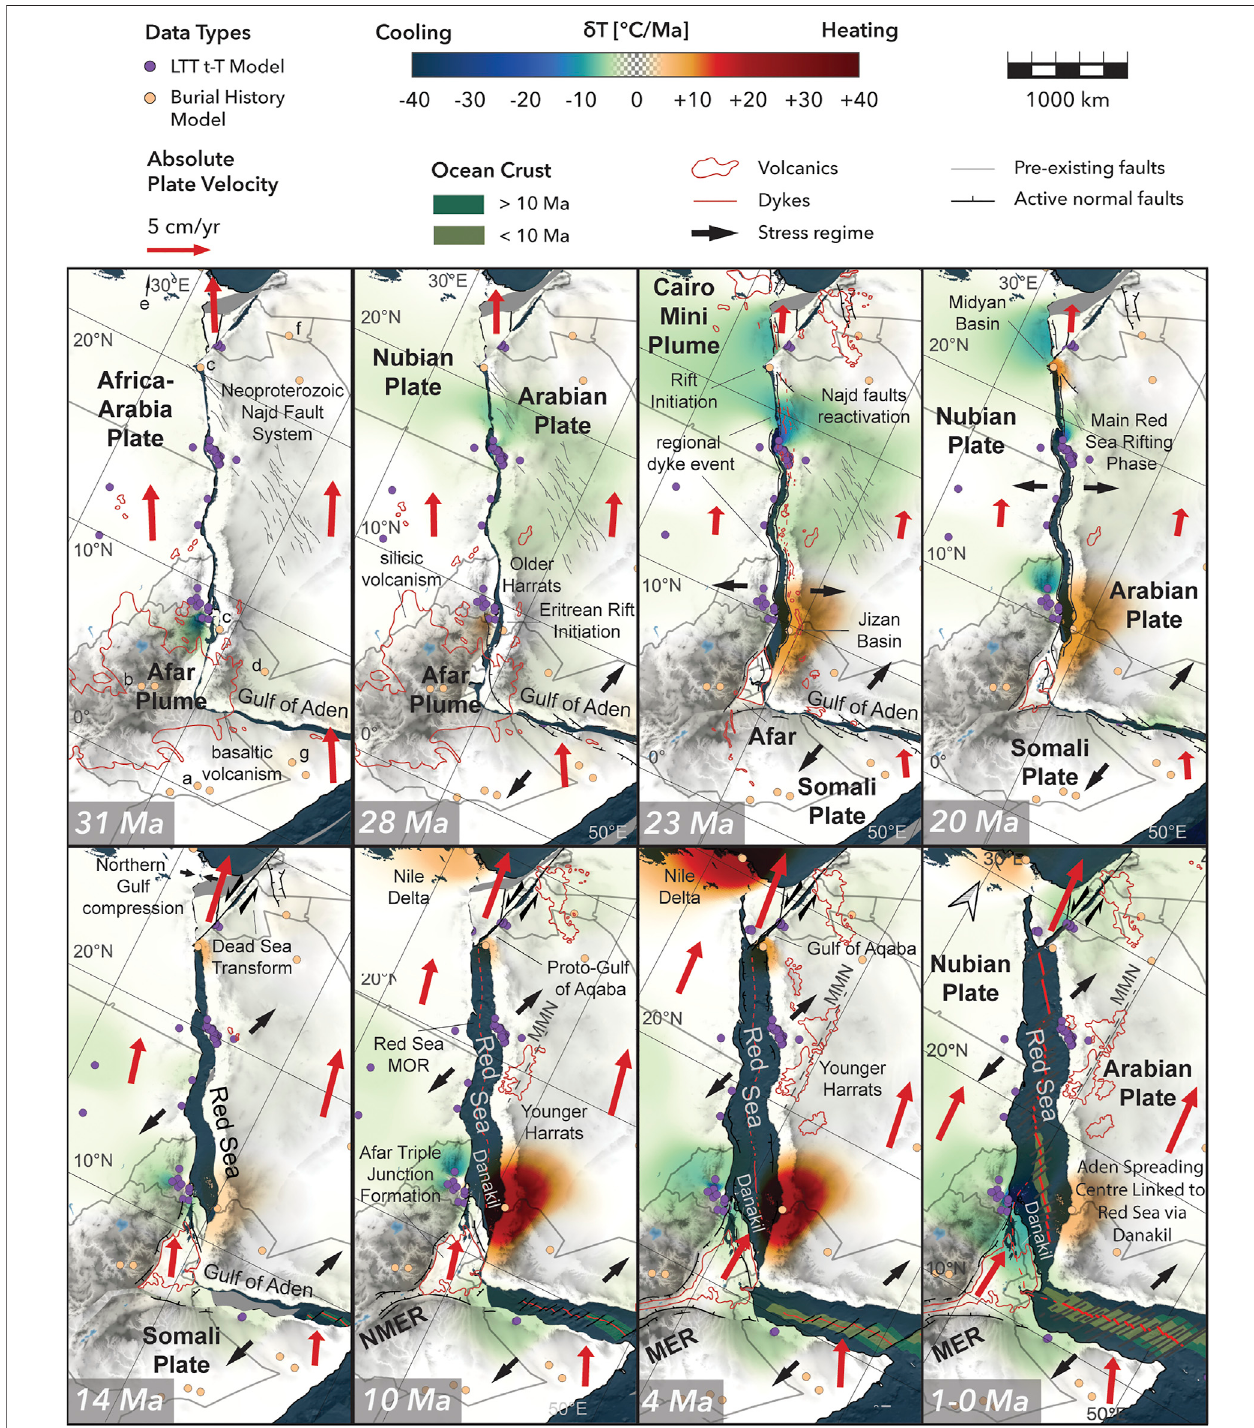
FIGURE2| PaleogeographicreconstructionsoftheopeningoftheRedSeaandabsoluteplatevelocitiessince31 Ma(rectangularprojectioncenteredontheArabianPlate afterMülleretal.,2016)overlainbycooling-heatingmaps.Cooling-heatingmapsweregeneratedbyperforminginversedistanceweightedinterpolations(distancecoef fi cientPof5) of δ T ° Casrecordedbypublishedbest- fi ttime-temperaturemodelsgeneratedfromlow-temperaturethermochronology(LTT)data(purplecircles – refertostudylocations 1,2,3,5, 8,9,12,14,18,19 in Figure1 )andwelldata(orangecircles: a Tsegayeetal.,2018; b Wolela,2007; c Coleetal.,1995; d Al-Areeqetal.,2018; e Keshtaetal.,2012; f Nayloretal., 2013; g AliandLee,2019-locationsin31 Mapanel).Simpli fi edstructuresafterThiéblemontetal.(2016)andBosworthetal.(2005).AgeofRedSeamidoceanicridge(MOR)after Augustin et al. (2021). Syn-rift igneous rock locations after Bosworth and Stockli (2016). (N)MER, (North) Main Ethiopian Ridge; MMN, Makkah-Madinah-Nafud volcanic line.